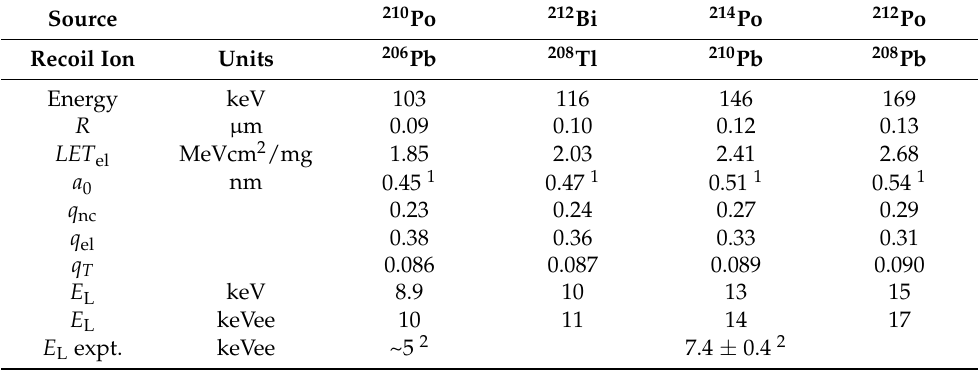
Table 2. Quenching factors q T , q nc and q el and the energy available for scintillation, E L , estimated for Pb and Tl ions in α -decay in liquid argon. The nuclear quenching factor q nc was taken from Ling